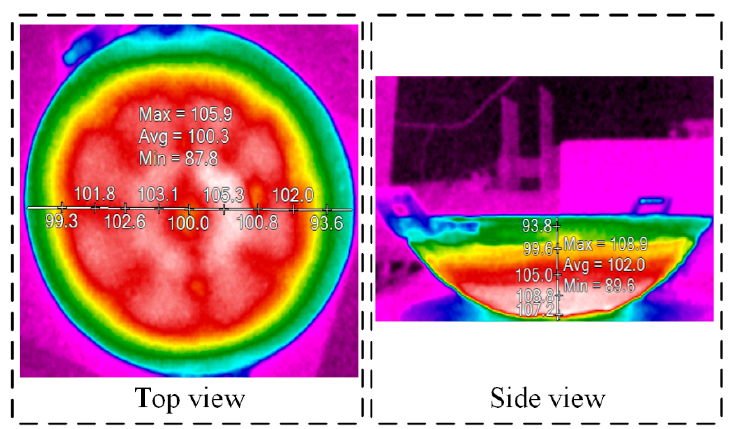
Figure 17. Thermal images of the wok from the top view and side view.